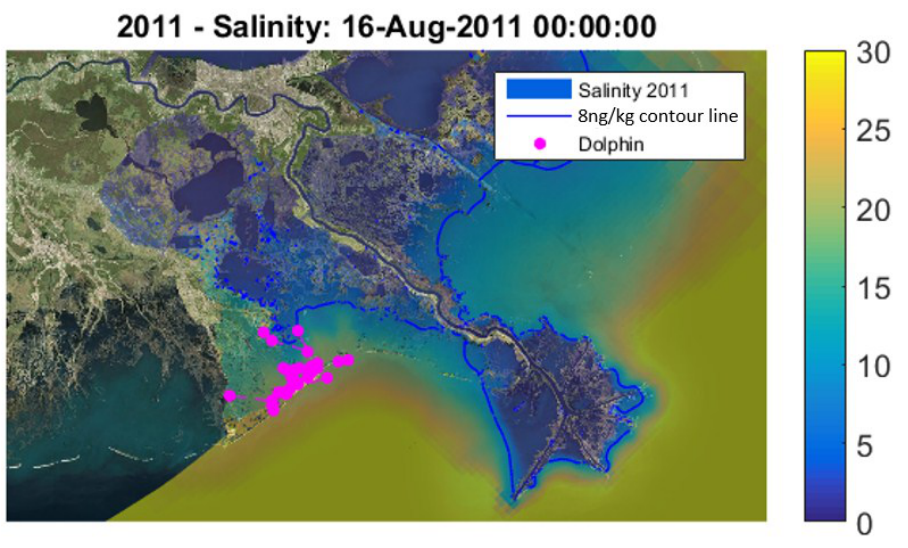
Figure 16. Basin-wide salinity model output (ng/kg) and dolphin locations (pink dots). Example for 2011 simulation.